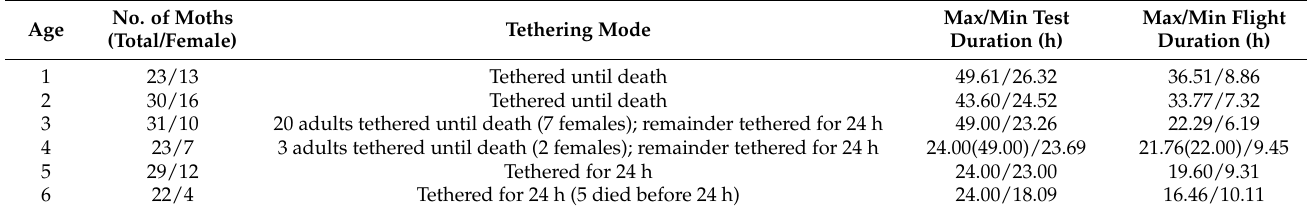
Table 1. Summary of tethered S. frugiperda at different